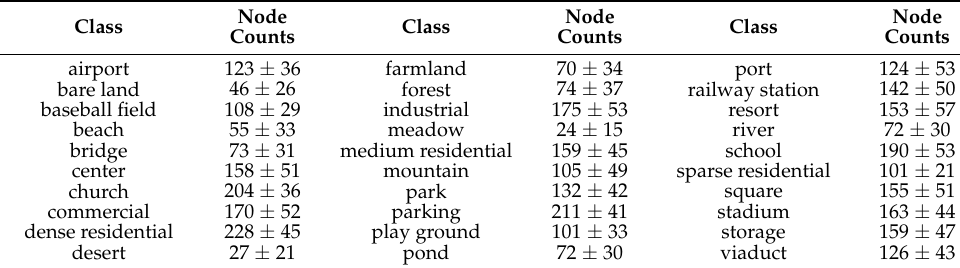
Table 6. Node counts of each category in the AID